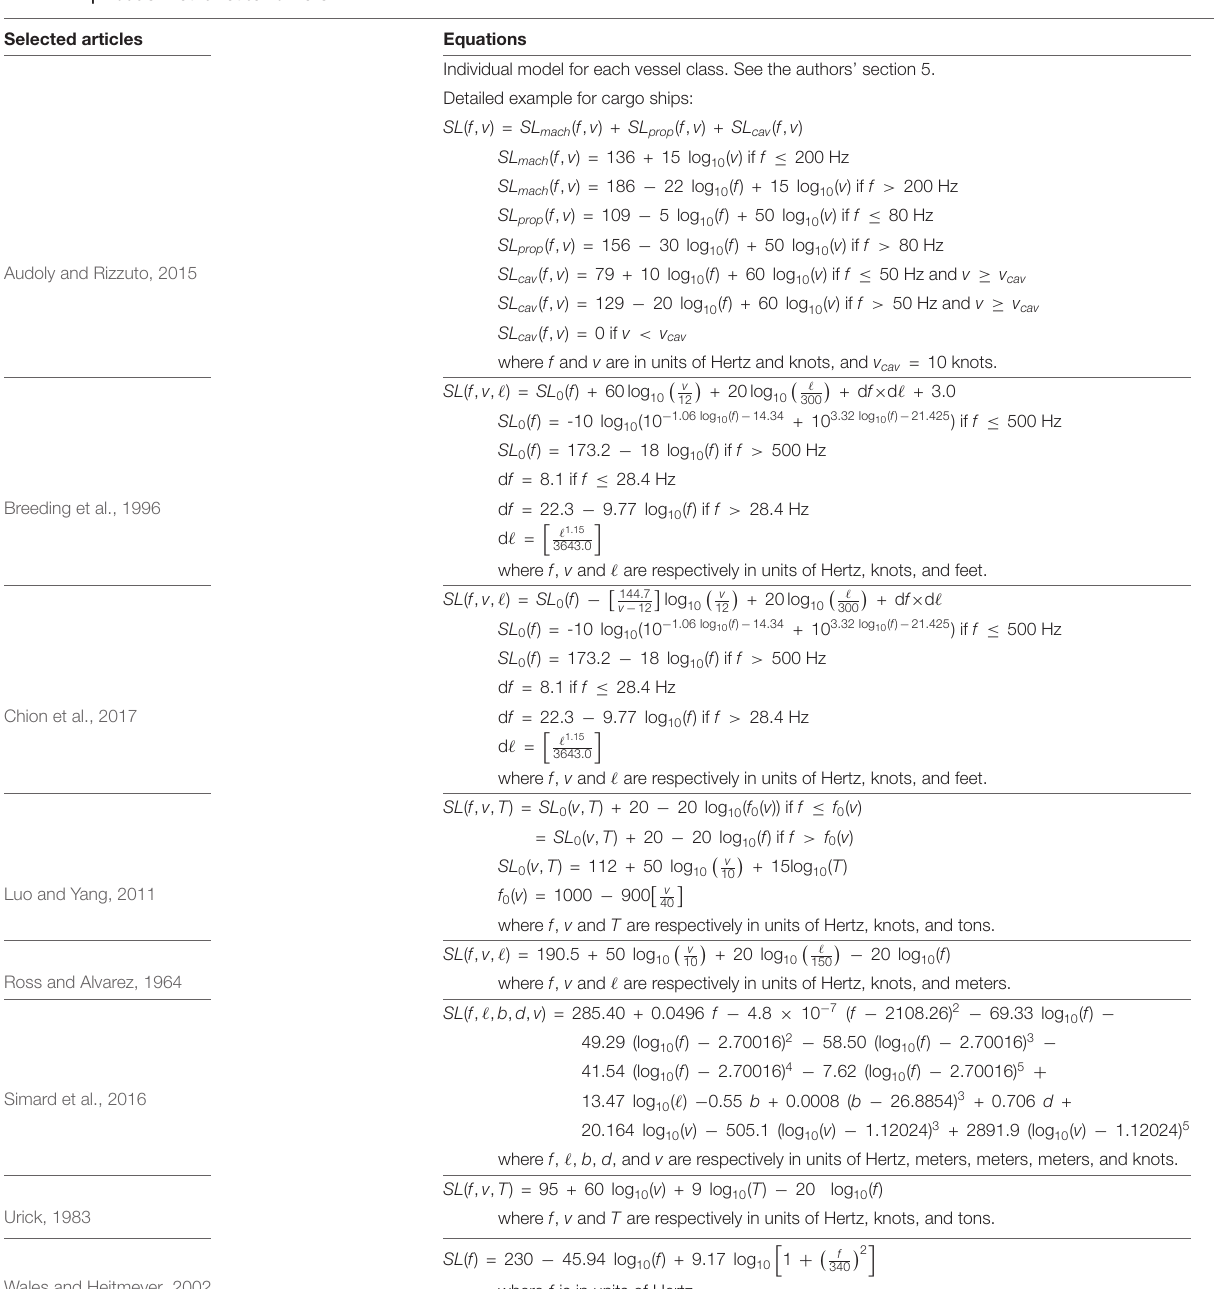
TABLE A1 | Models’ mathematical formalism.